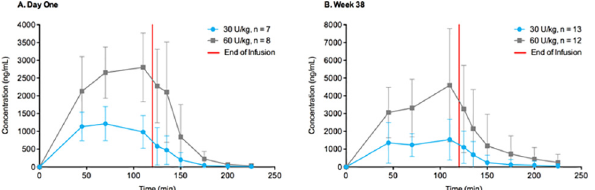
Fig 1. Taliglucerase alfa plasma concentration in adult patients. Mean plasma concentration-versus- time curve of taliglucerase alfa in adult patients for 120-minute infusions showing dose-dependent increase (linear plot): a) on day 1; b) at week 38. Abbreviation: U/kg, Units/kg. Error bars represent standard